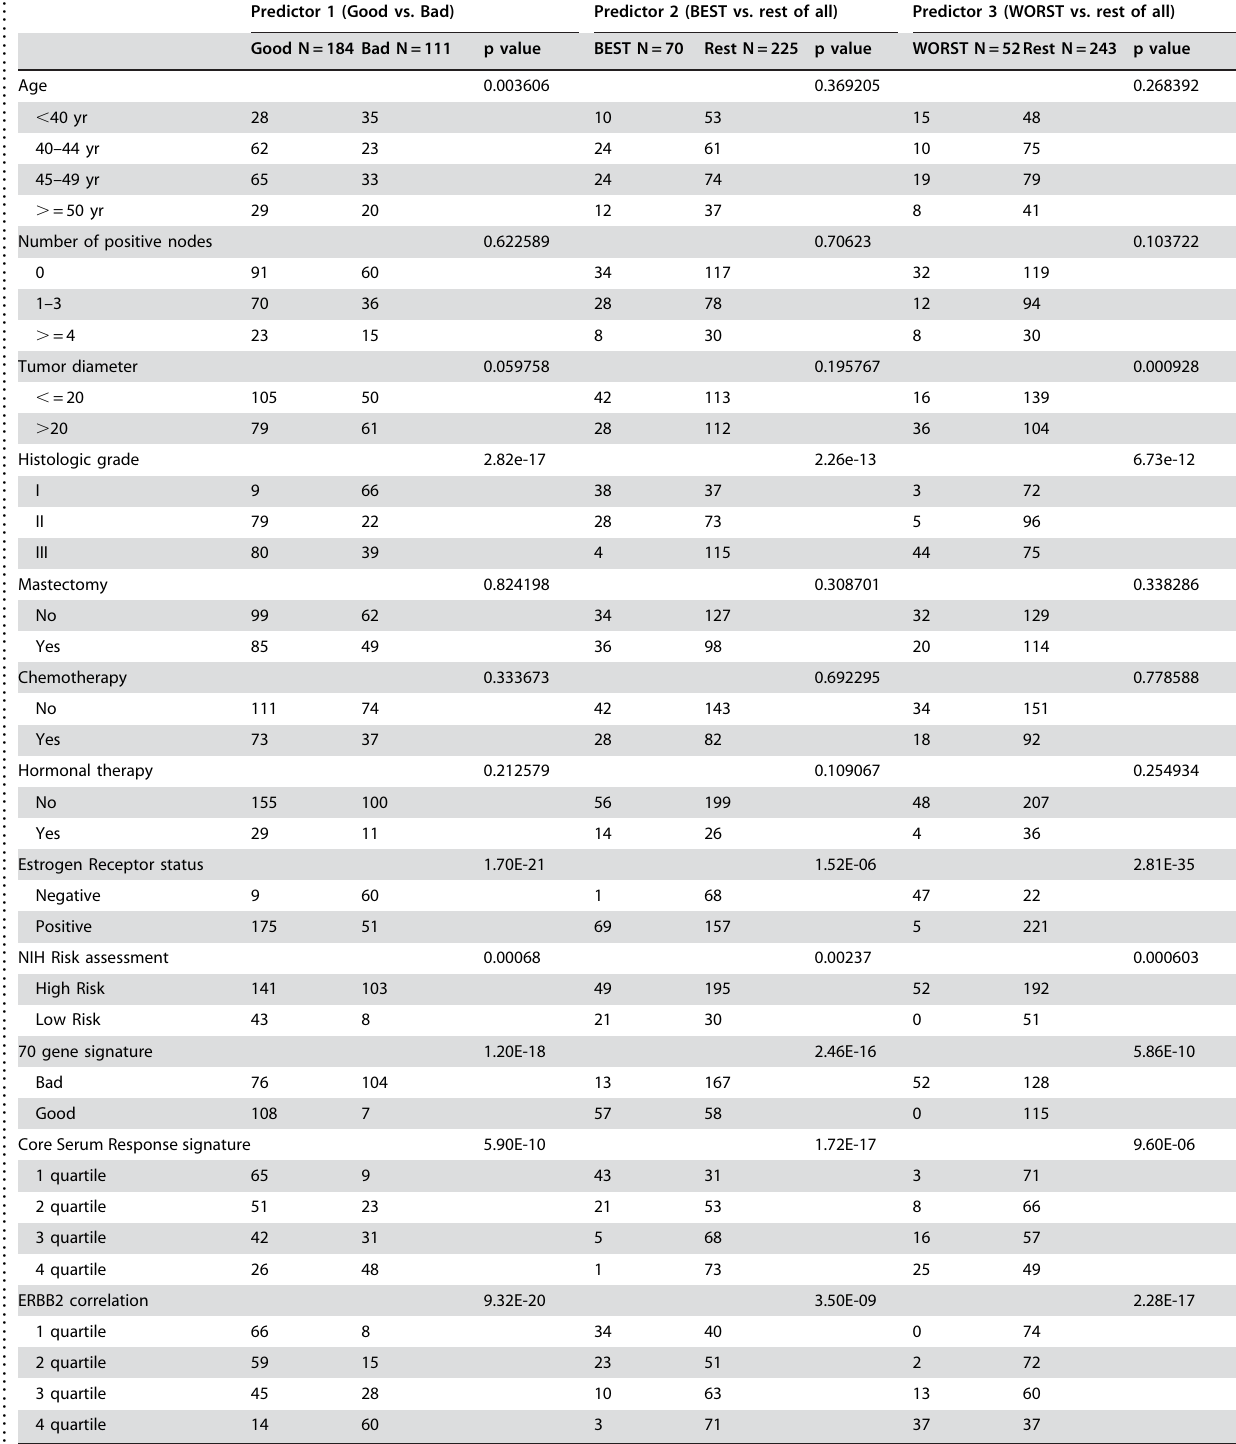
Table 1. Association study of prognosis prediction model with clinical index using the NKI data set. .. ... .... ... ... .... ... ... .... ... ... .... ... ... .... ... ... .... ... ... .... ... ... .... ... ... .... ... ... .... ... ... .... ... ... .... ... ... .... ... ... .... ... ... . Predictor 1 (Good vs.